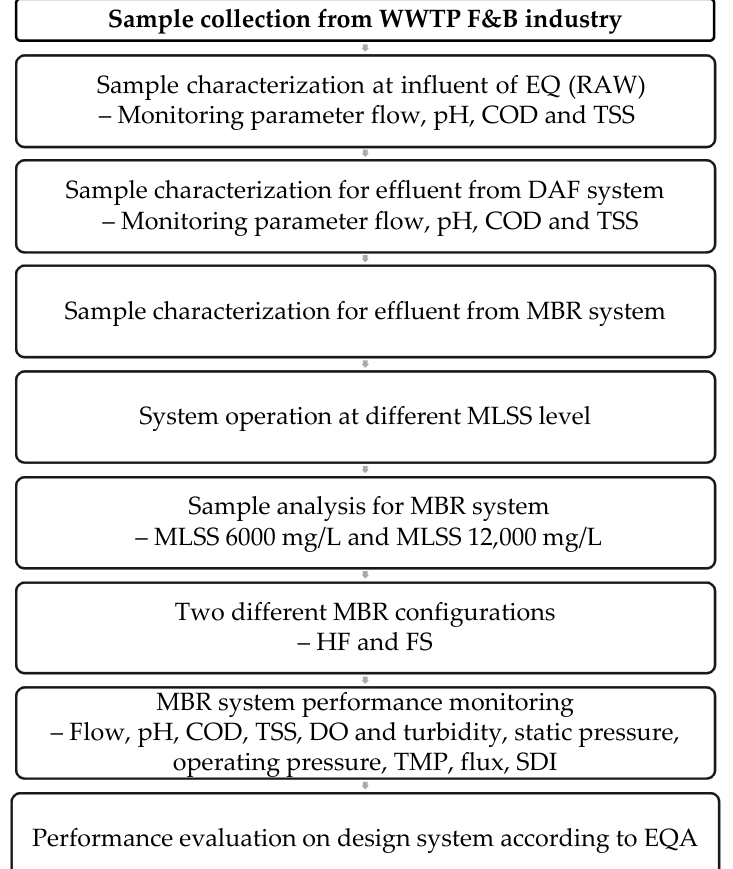
Figure 2. Process flow of study.